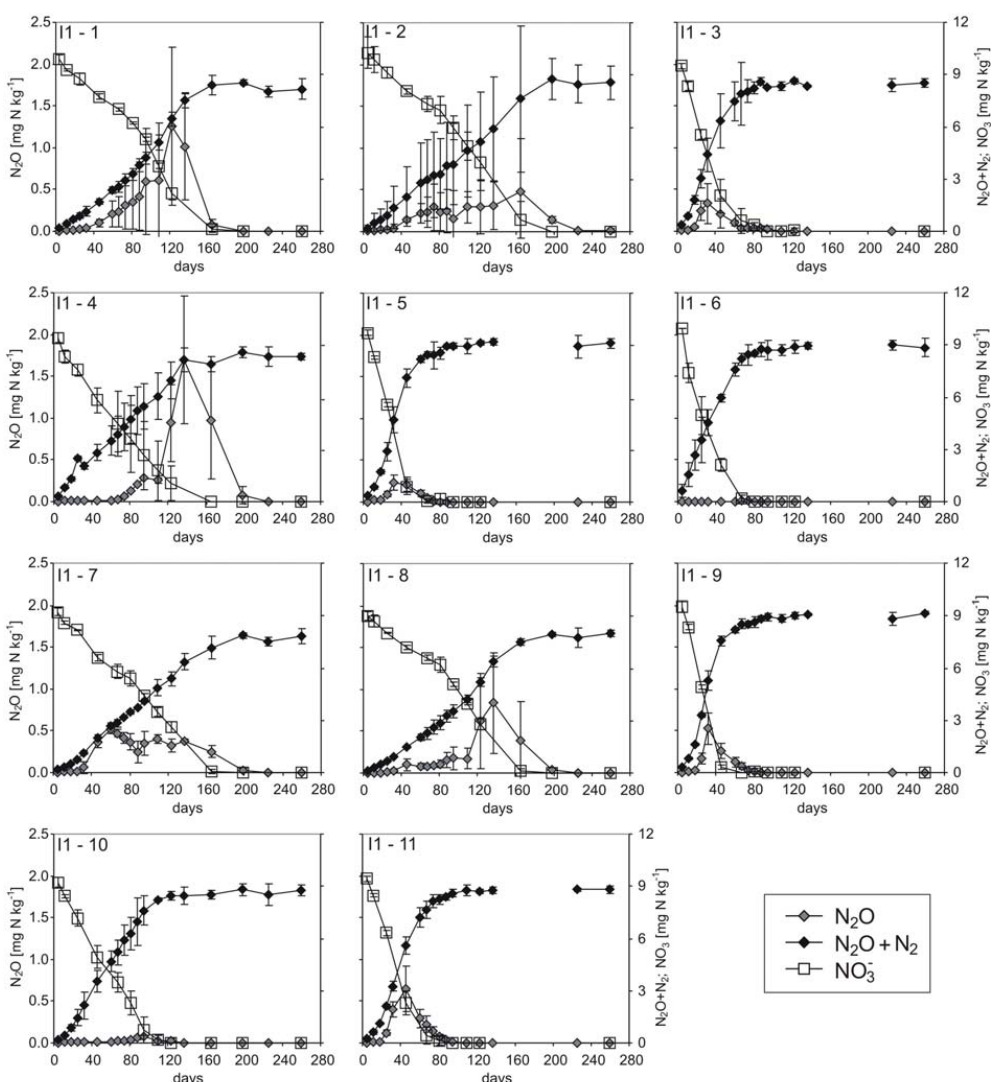
Fig. 3. Concentration courses of N 2 O, N 2 O+N 2 , and NO − during long-term anaerobic incubation of aquifer material from the autotrophic 3 denitrification zone. The symbols denote the means of 4 replications and the error bars represent the standard